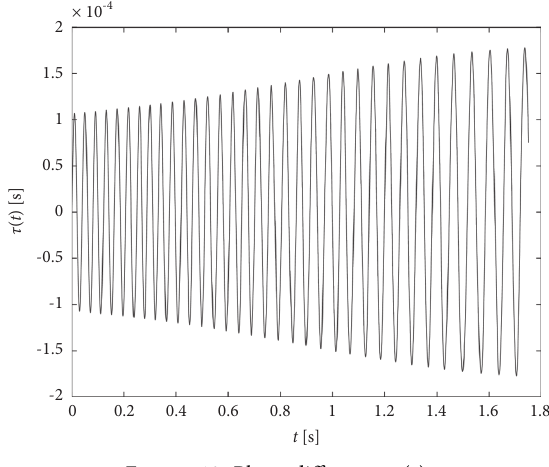
Figure 12: Phase difference τ ( t ) . ( t ) . 0